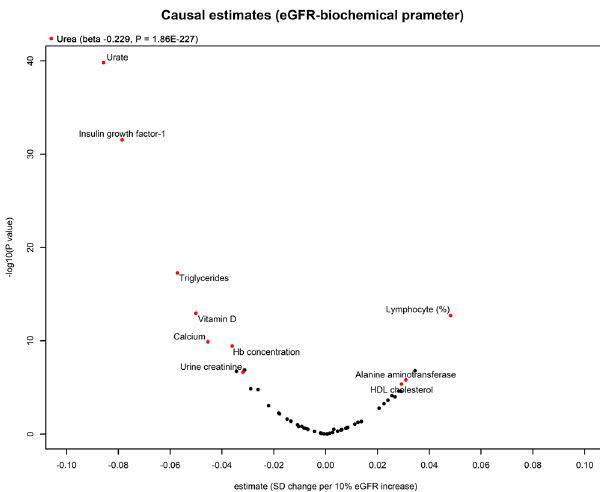
Fig. 2 Summary plot demonstrating the estimate effect sizes and signi fi cance level ( P -values). The X -axis indicates the causal estimate effect sizes (by the fi xed-effects inverse variance – weighted method), which were normalized to a 10% eGFR increase per standard deviation change in a biochemical parameter. The Y -axis indicates the -log 10 ( P -value) to demonstrate a biochemical with a lower P -value to be presented in the upper part. The names of the biochemical parameters with signi fi cant causal estimates toward both by inverse variance – weighted, MR-Egger, and weighted-median methods are presented. The dots for the consistently signi fi cant fi ndings are presented as red. As the causal estimates toward urea, which was the most prominent signi fi cant fi nding, had very low P - value, the parameter is separately marked in the left-upper corner of the fi